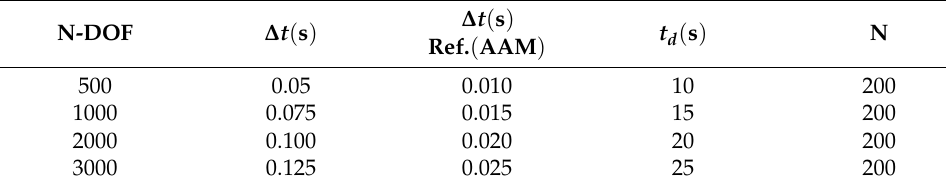
Table 2. Time integration data. Table 3. Initial and highest natural frequencies.